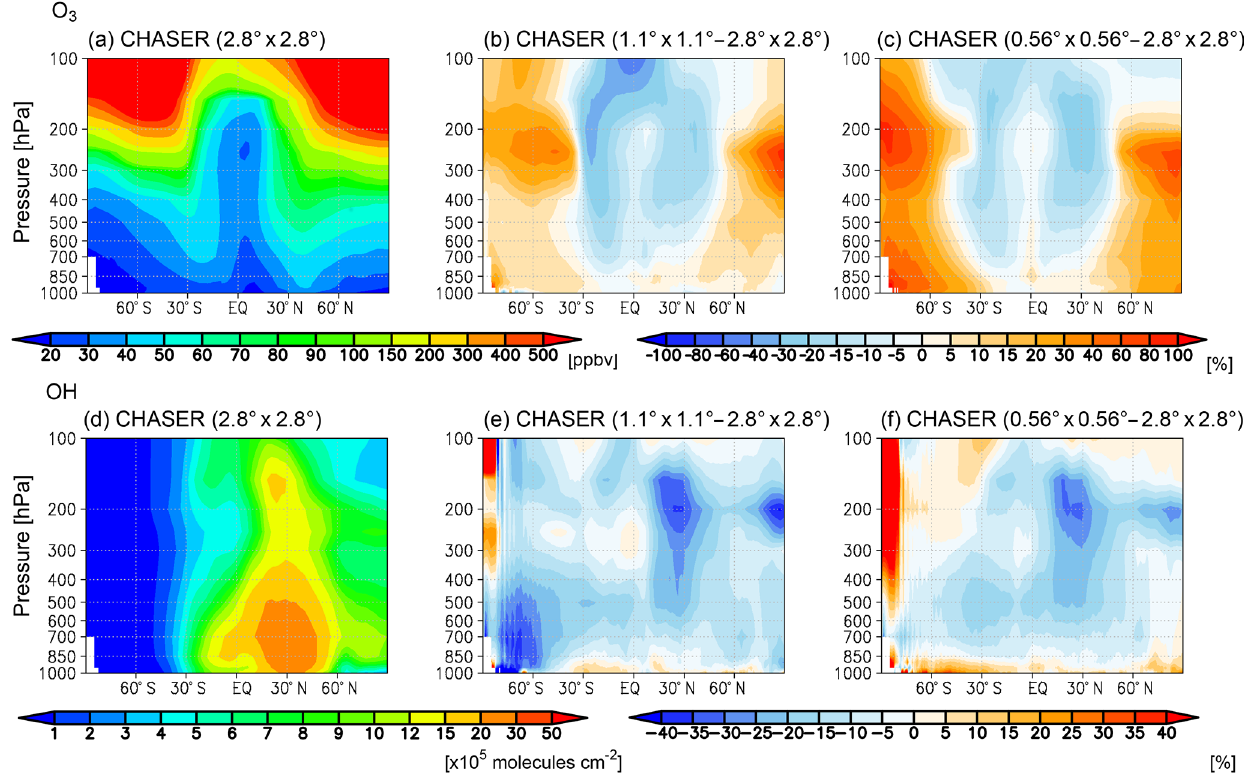
Figure 12. Latitude–pressure distribution of zonal mean (a–c) O 3 (ppbv) and (d–f) OH ( × 10 5 moleculescm − 3 ) in the model simulation at 2.8 ◦ (left column) during JJA in 2008 and differences between the model simulation at 1.1 ◦ (middle column) and 0.56 ◦ (right column) resolutions and the model at 2.8 ◦